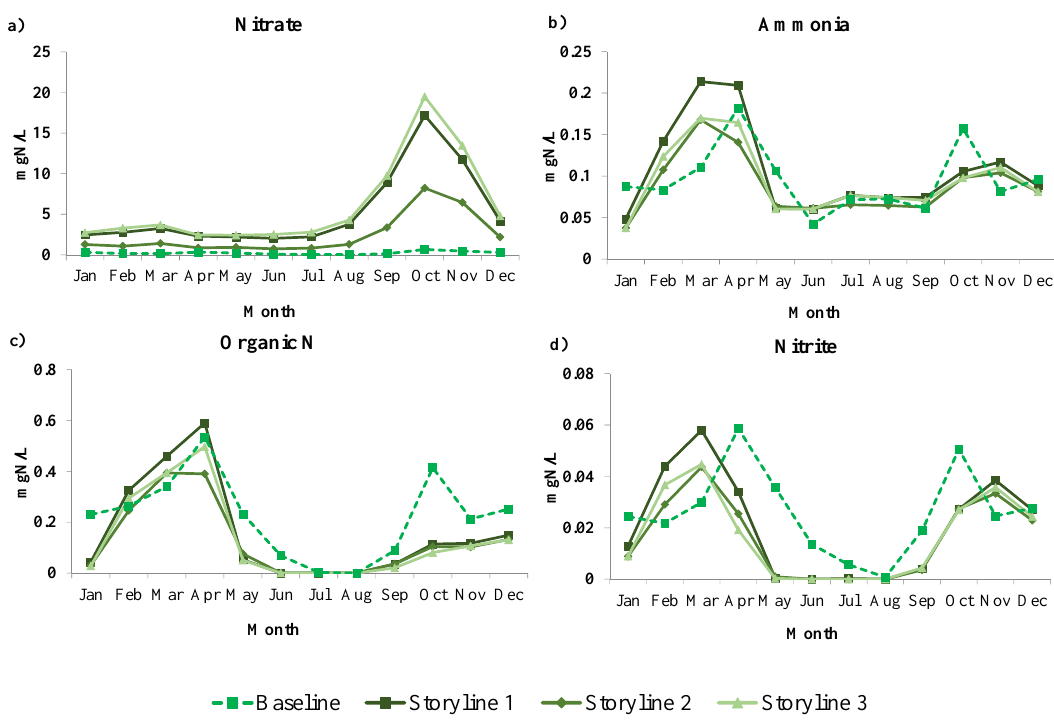
Figure 9. The monthly evolution of the N forms (mg N L − 1 ) for each storyline (timeline 2060 and GFDL climate model) and baseline condition: ( a ) Nitrate; ( b ) Ammonia; ( c ) Organic N; and ( d ) Nitrite.